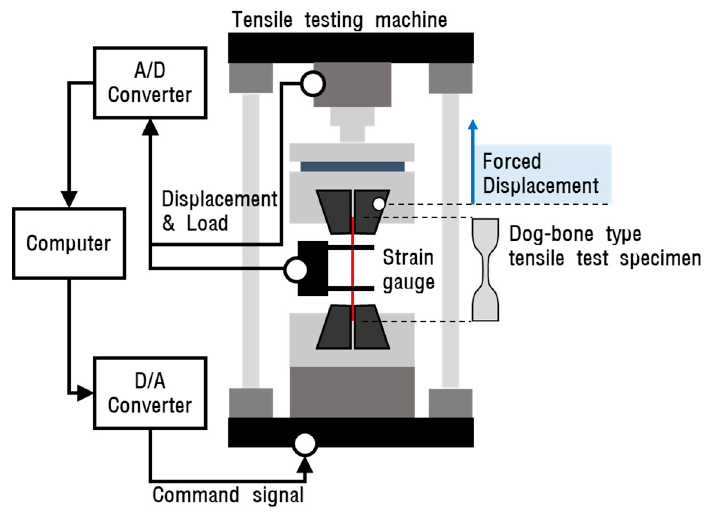
Figure 2. Schematic of the KS M 6518 tensile test.